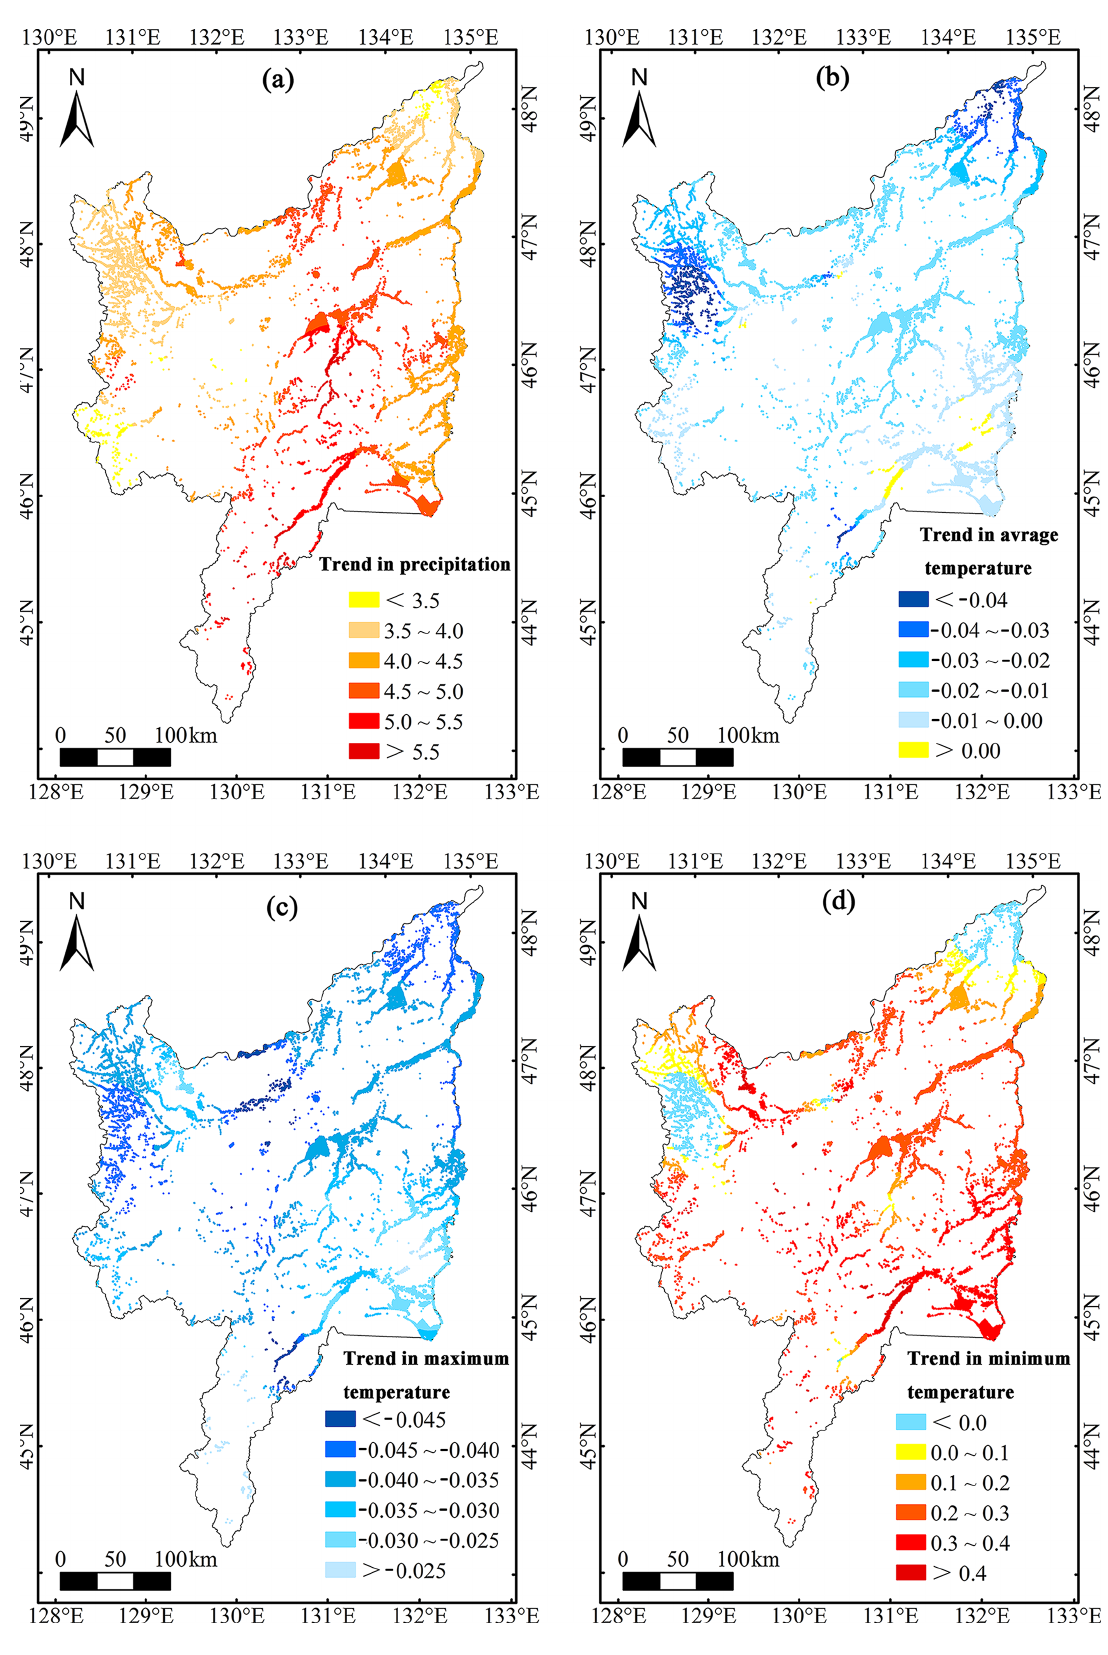
Figure 9. Change trends in August ( a ) precipitation (mm/year), ( b ) T mean (°C/year), ( c ) T max (°C/year) and ( d ) T min (°C/year) in the study region from 2000 to 2020.